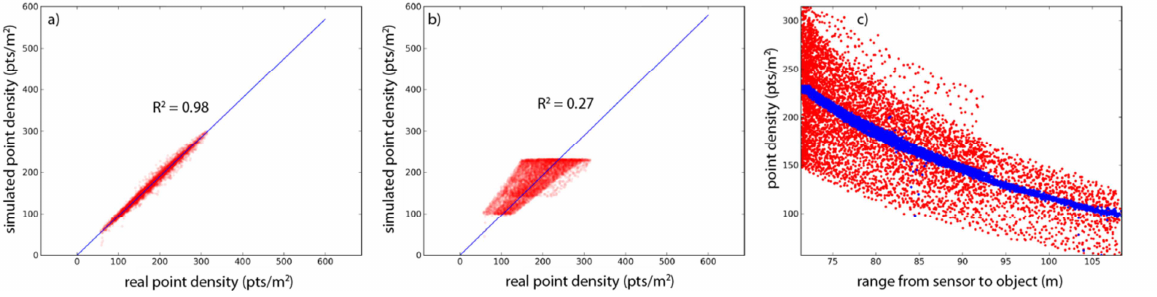
Figure 8. Comparison of real and simulated point densities for model airfield: a) scatterplot of the relationship between real point densities and simulated point densities (flown trajectories); b) scatterplot of the relationship between real point densities and simulated point densities (planned trajectories); c) scatterplot of the relationship between scan range and point density for simulated data (planned trajectory = blue and real data = red)